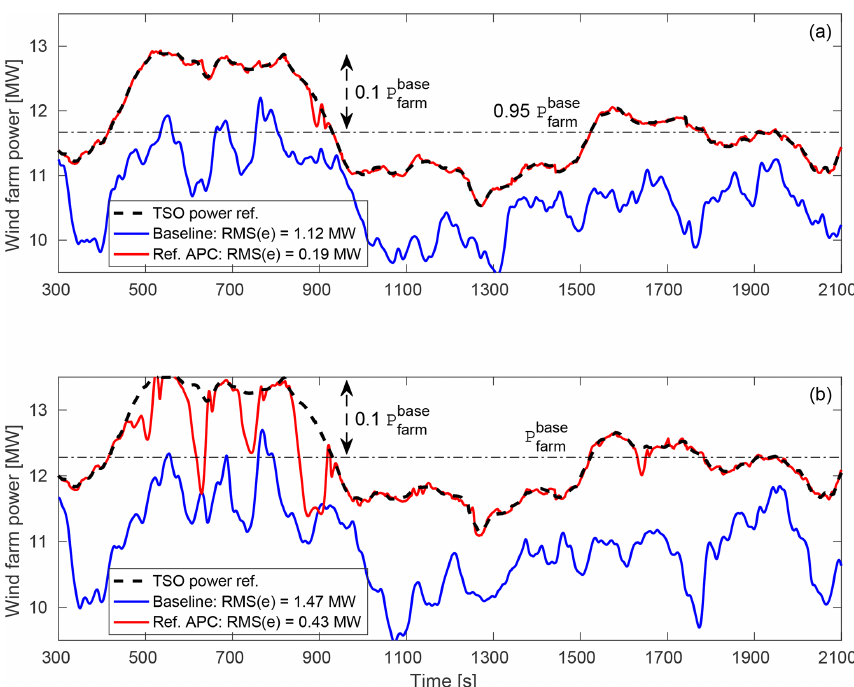
Figure 9. Total power production of the wind farm with closed-loop APC, compared with the baseline. Both controllers rely on constant power set-points α i = 1 / 12 for equally distributing the AGC power reference among the wind turbines with indices of i = 1 ,..., 12. The = 12 . 3MW, b = 95% (a) , b = 100% (b) , and c = 10%. P base time-varying power reference parameters Eq. (23) are chosen here as P base farm farm represents the time-averaged wind farm power with locally greedy induction factors a i = 1 / 3 (see Fig.